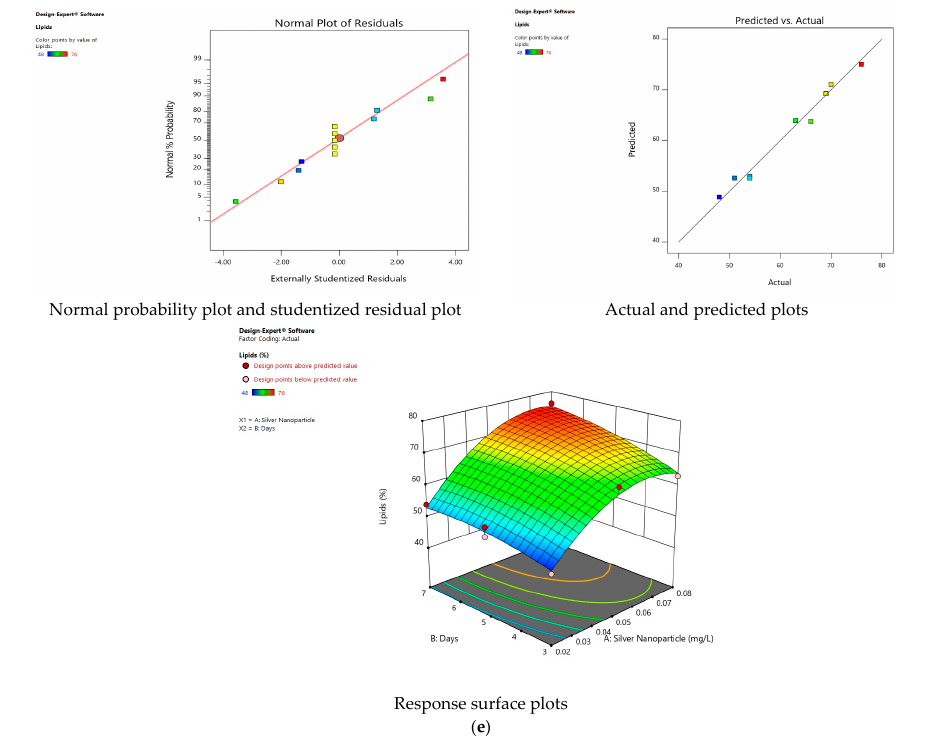
Figure 3. Response surface plots of ( a ) growth, ( b ) carbohydrates, ( c ) proteins, ( d ) chlorophyll and ( e ) lipids in Cladophora sp. Color based on response value, as blue color shows the minimum points and red color shows the maximum points, pink color indicates points below predicted value